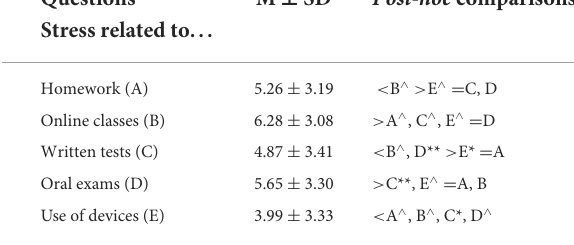
TABLE 3 Mean and standard deviation (SD) for distance learning perceived